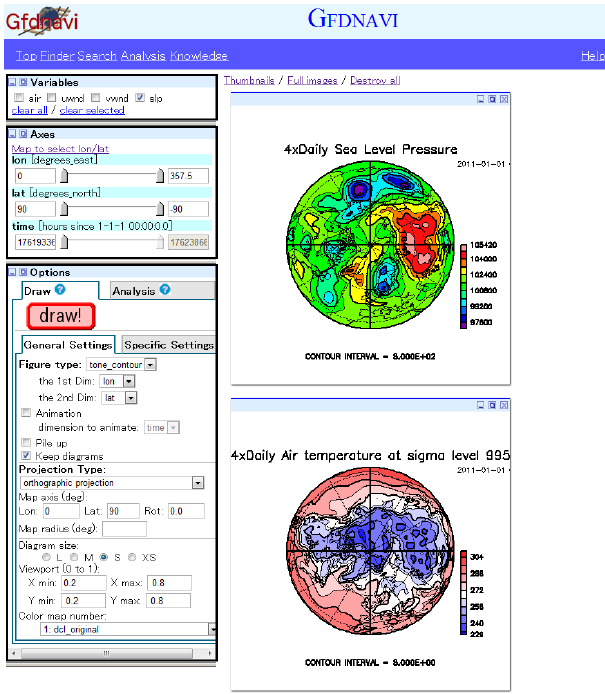
Fig. 2. A screenshot of web-based data and knowledge server software, Gfdnavi.